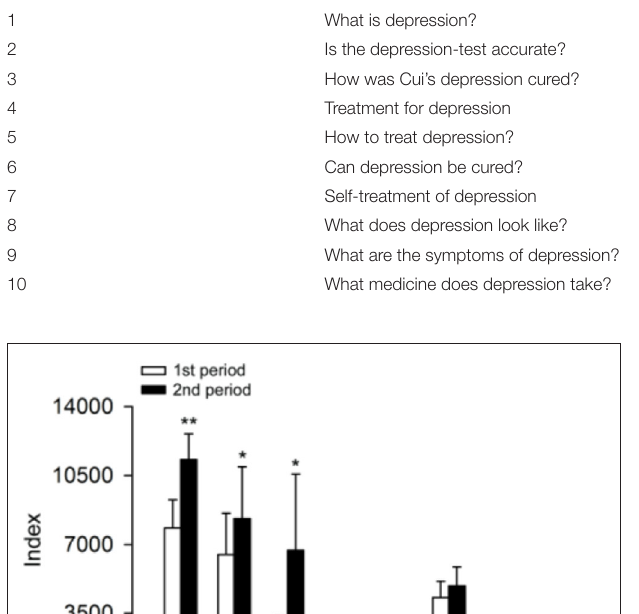
TABLE 2 | Top 10 depression-related topics on Baidu: 1 September 2015 to 30 September 2017. Rank